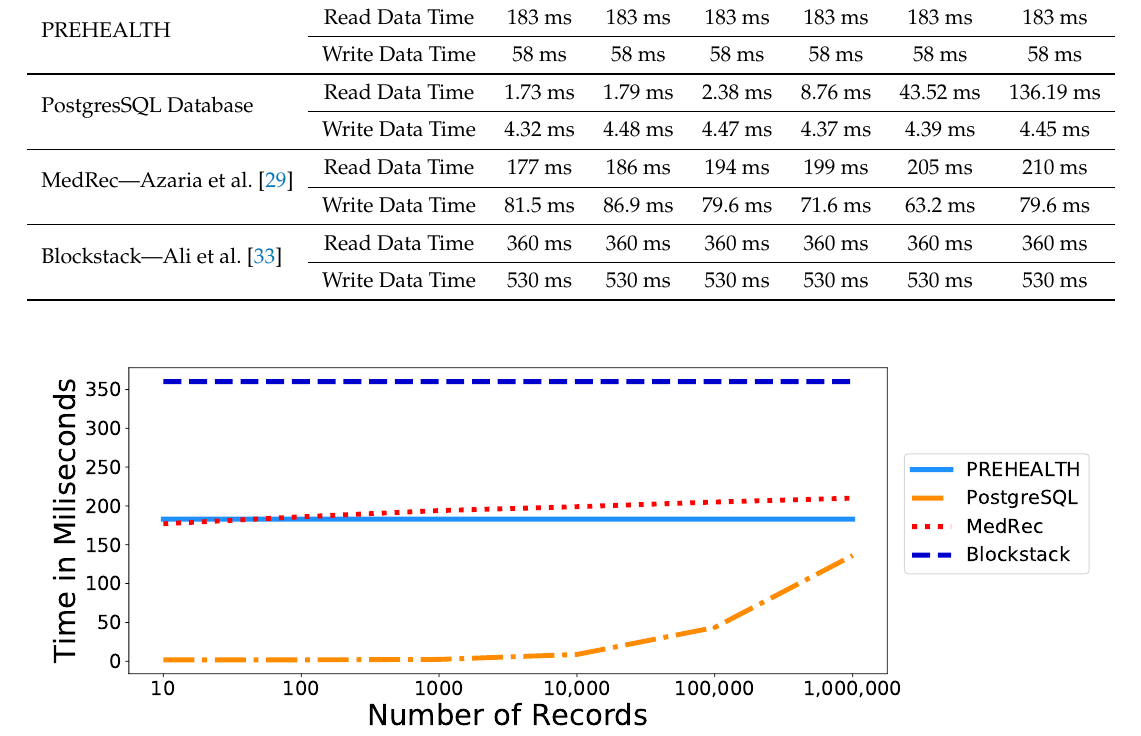
Figure 4. Read records transactions